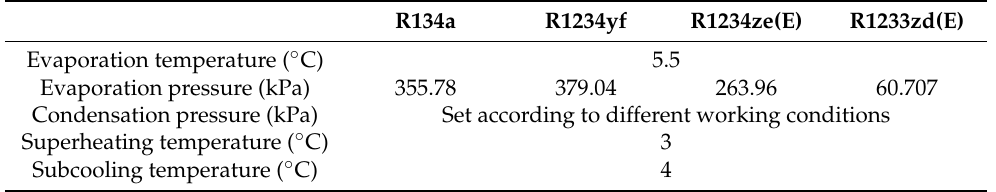
Table 3. Working conditions of centrifugal chiller system.